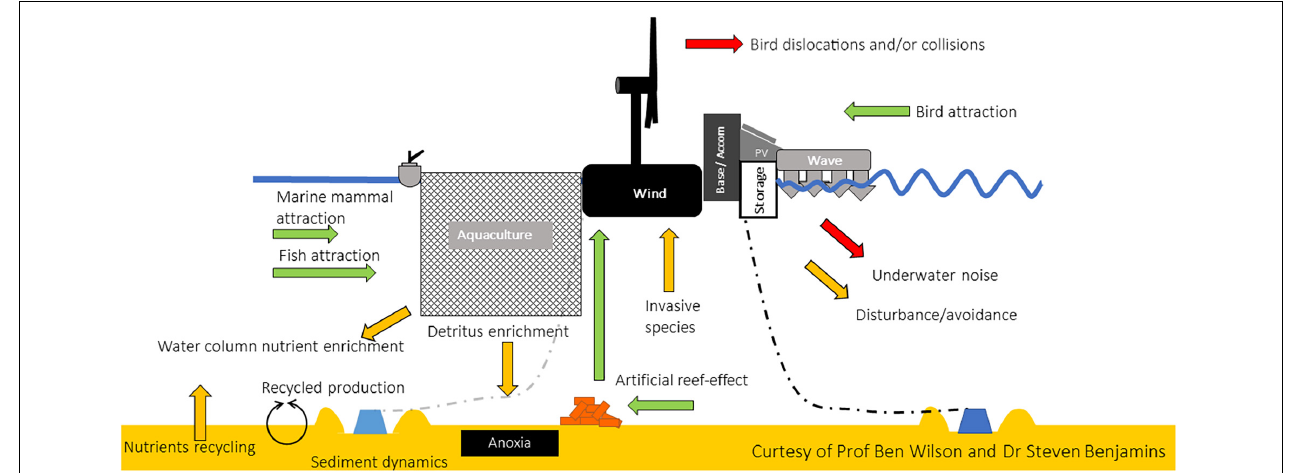
FIGURE 1 | Schematic representation of potential environmental interactions of a hypothetical MPP structure, including aquaculture activity (e.g., fish pens, a barge, and associated mooring structures) co-located with wind turbines, wave device converters, solar PV panels and on board energy storage capacity. Green arrows indicate potential for attraction of species (fish, mammals, birds, epifauna); yellow arrows indicate potential wider ecosystem impacts (substrate availability for invasive species, detritus enrichment, enhanced recycled production, noise); red arrows indicate potential adverse/lethal impacts (dislocations and collisions of birds and bats with wind turbines; underwater